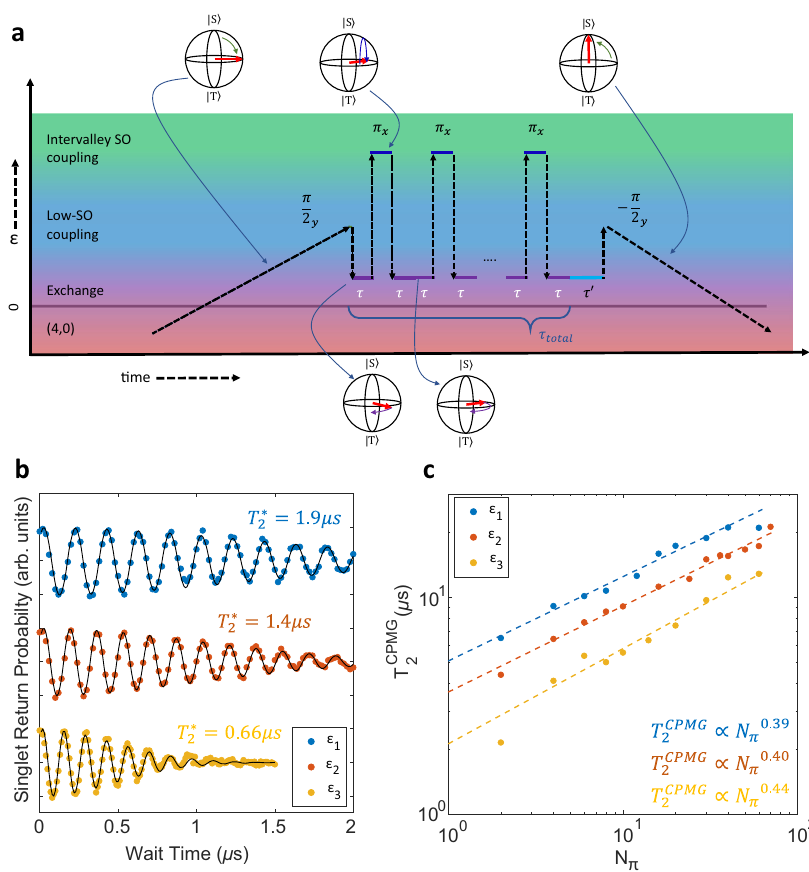
Fig. 4 Decoupling from charge noise with CPMG. a Schematic for CPMG pulses. We initialize the qubit into the (4,0)S ground state and ramp adiabatically, such that the qubit transfers to the ground state ( ↑↓ or ↓↑ ) in the (3,1) charge sector at moderate detuning, away from the spin-valley hot spot. This acts as an effective π /2 pulse about the Y-axis of the S - T 0 qubit basis. A fast pulse to and from a detuning, ϵ , where exchange is substantial, drives coherent rotations around an axis dominated by the exchange interaction. Here, charge noise drives qubit dephasing. A series of π pulses are then applied to decouple the qubit from charge noise. Here we operate with an intervalley spin – orbit driven rotation frequency of 20 MHz. A fi nal wait time, τ 0 , at the end of the sequence allows for the observation of the free induction decay of the refocused echo. Returning to the (4,0) charge sector adiabatically produces an effective − π /2 Y-pulse and projects the states onto the (4,0)S and (3,1)T 0 basis for measurement. b Qubit exchange rotations at three QD- QD detuning points. Black curves are fi ts to oscillating Gaussian decay envelopes / exp number of refocusing pulses N π for three QD-QD detuning points where exchange is the dominant spin interaction. Dashed lines are fi ts to the form T CPMG / N β π 2